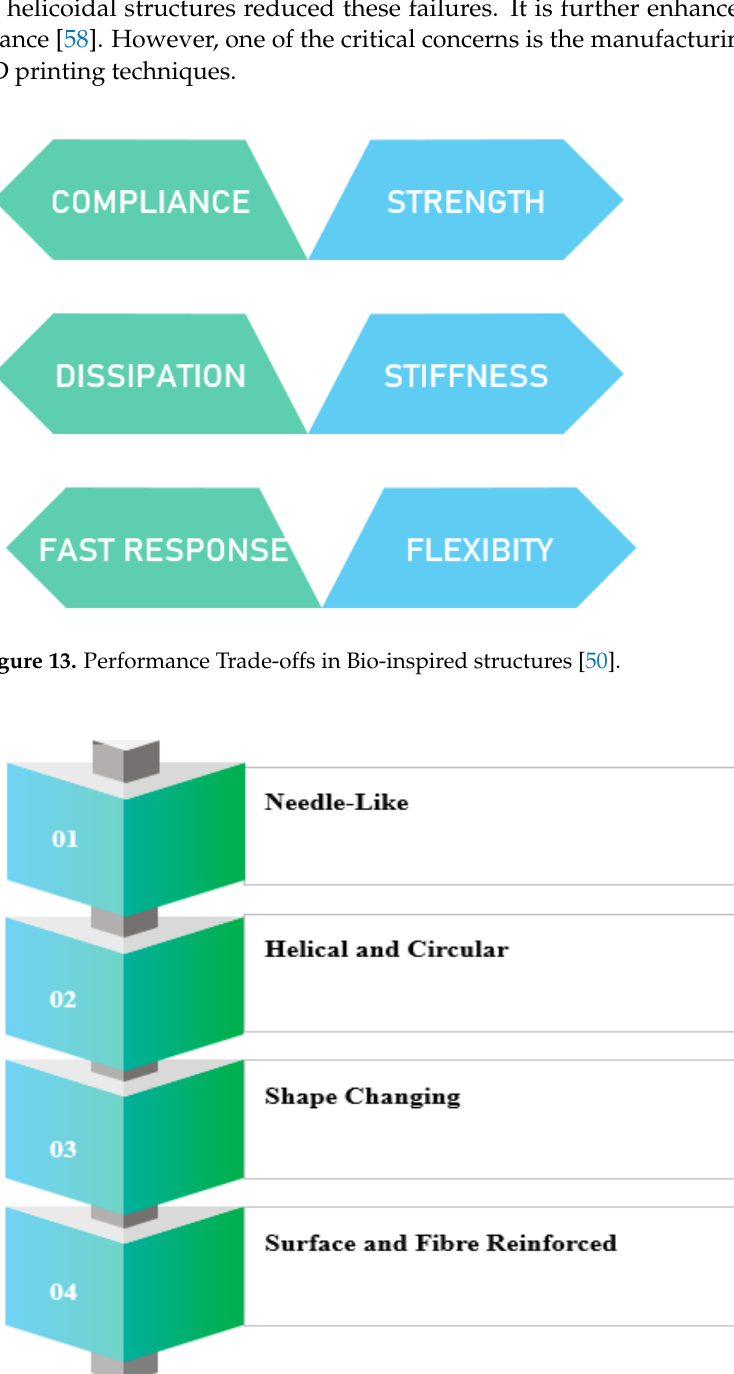
Figure 14. Bio-inspired Structure